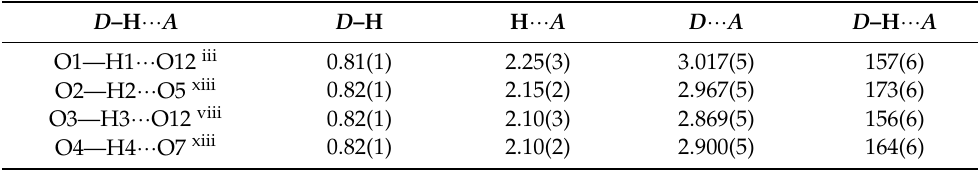
Table 5. Hydrogen-bond geometry (Å, ◦ ) for Cd 5 (VO 4 ) 2 (OH) 4 .